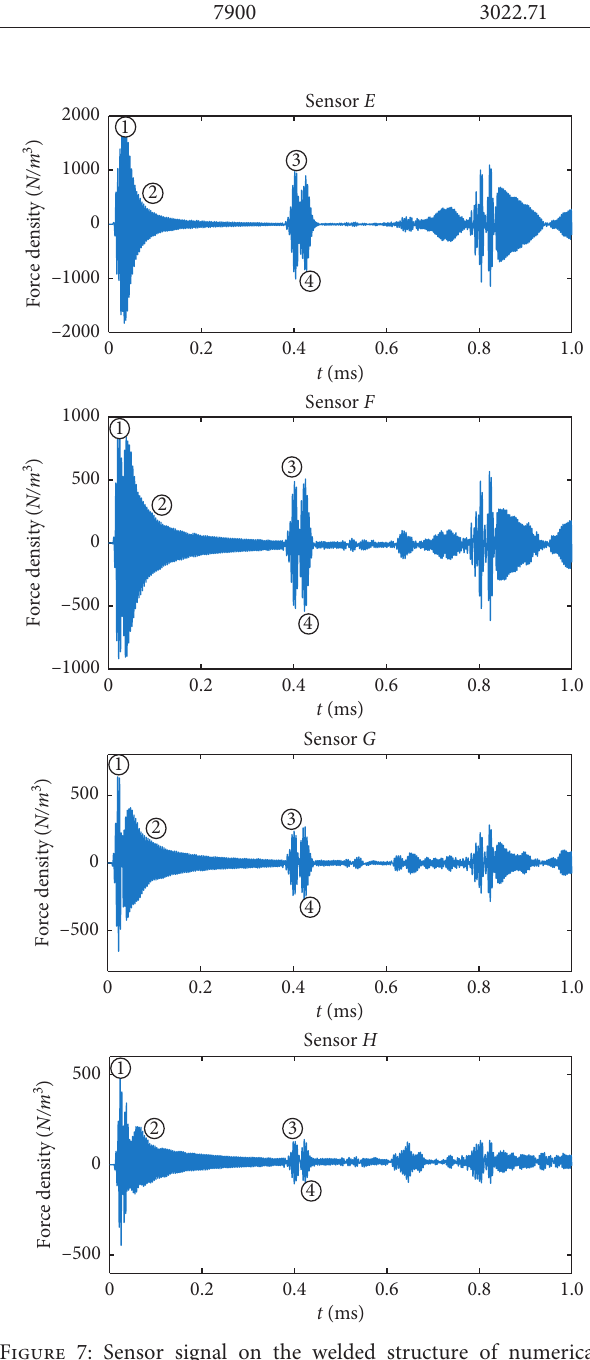
Figure 7: Sensor signal on the welded structure of numerical